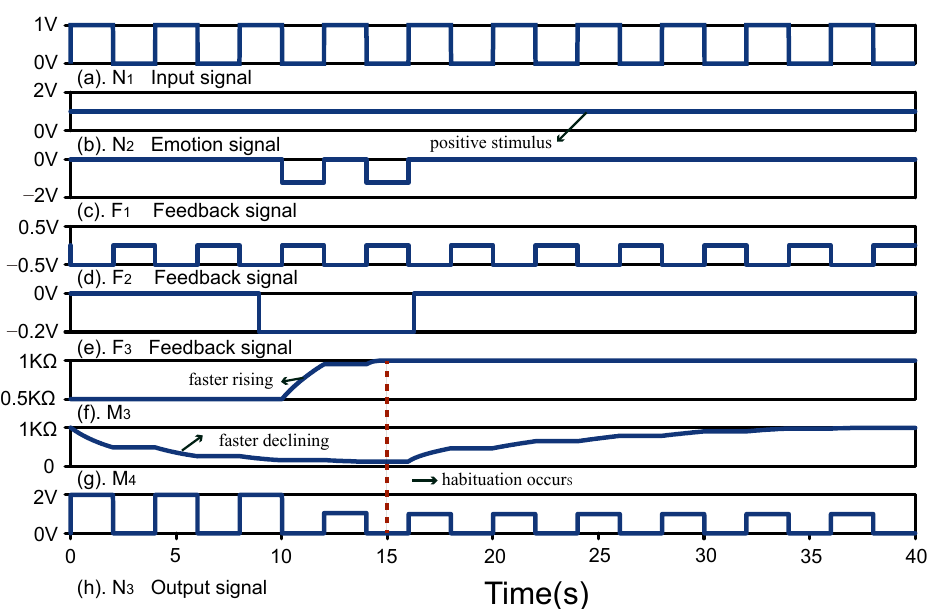
Figure 12. Habituation under positive stimulus. ( a ) Input signal. ( b ) Emotion signal. ( c ) Feedback signal F 1 . ( d ) Feedback signal F 2 . ( e ) Feedback signal F 3 . ( f ) Memristance of M 3 . ( g ) Memristance of M 4 . ( h ) Output signal N 3 .